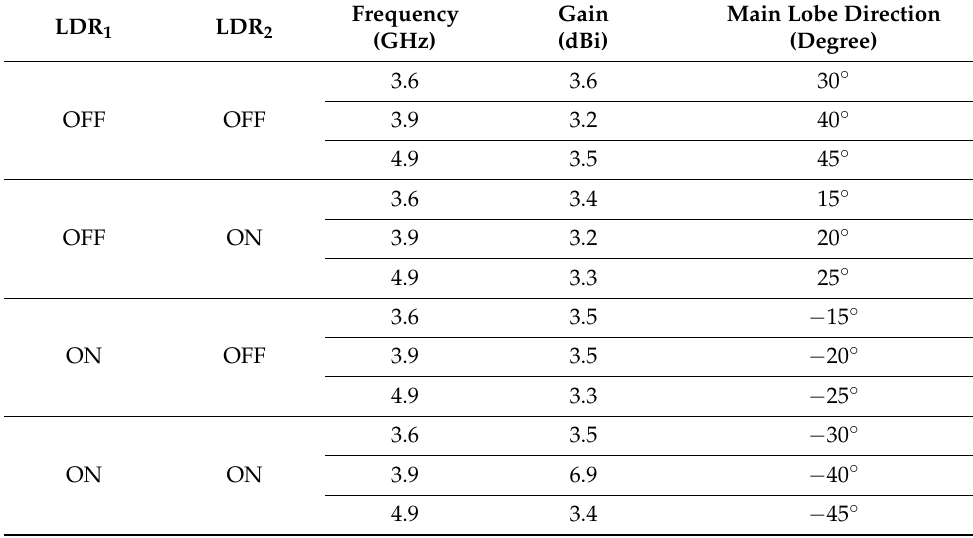
Table 1. Radiation properties with changing the LDR switching.